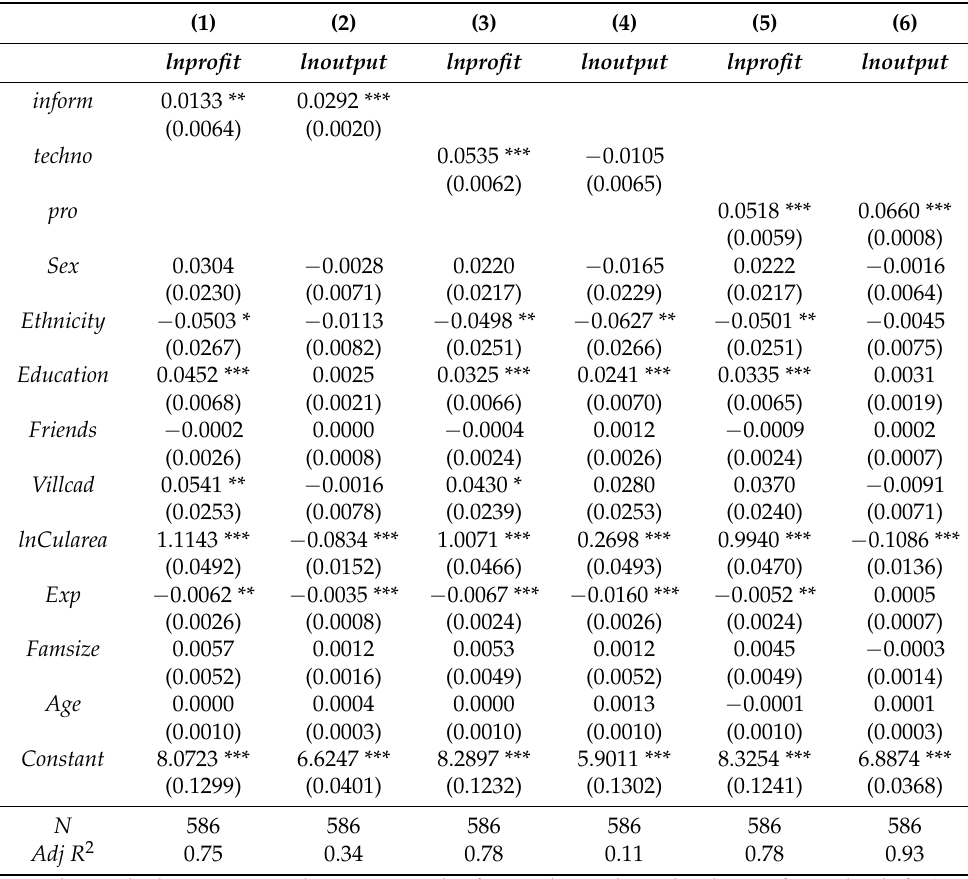
Table 5. Test results of the sources of benefits from cooperative